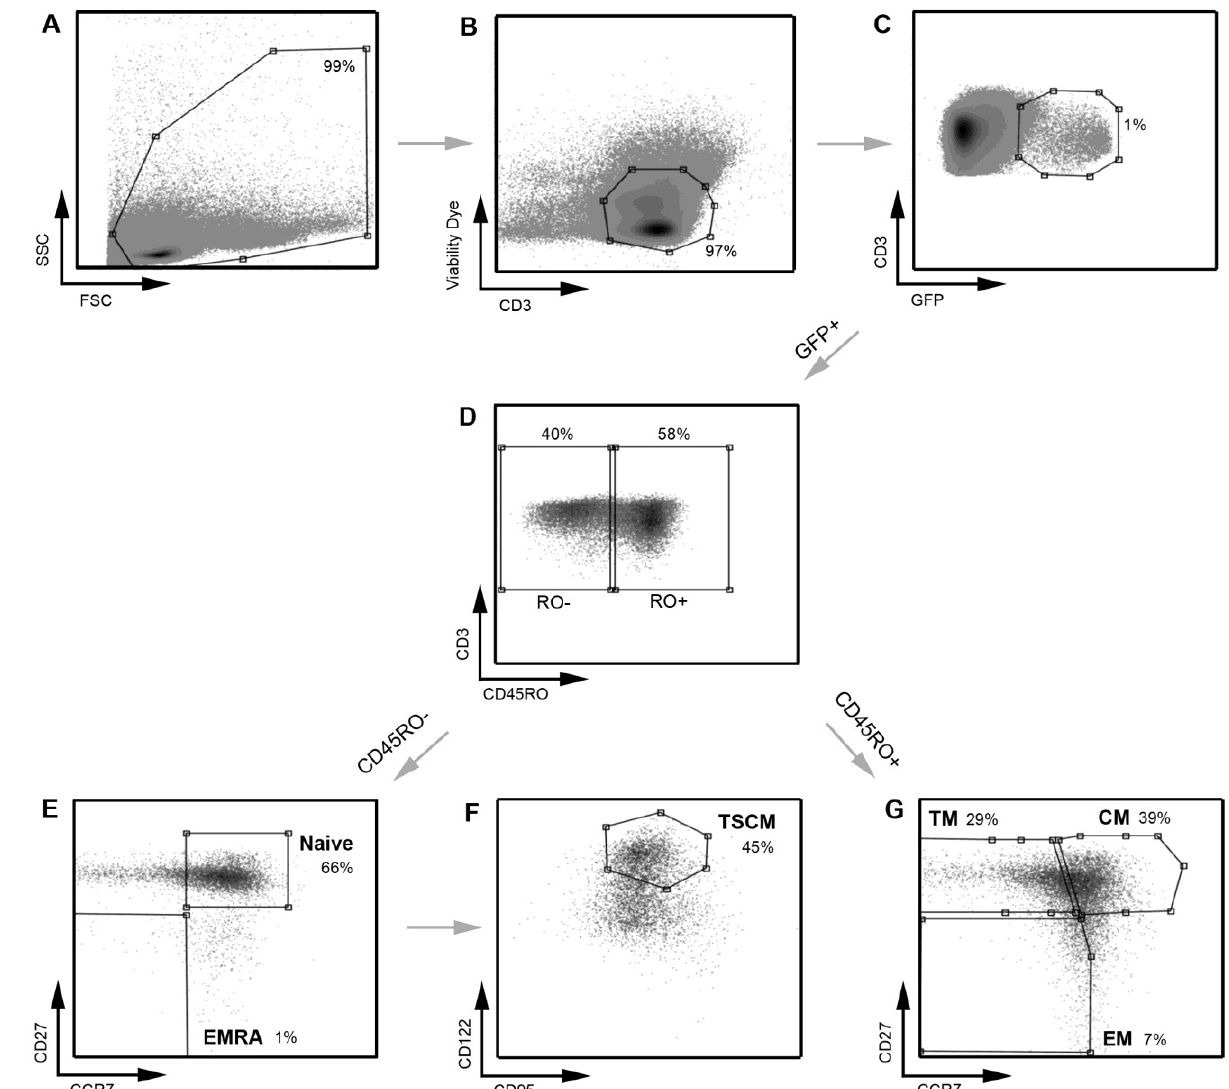
Figure 4. A representative example of the strategy used to define infected CD4 + T cell subsets. A similar gating strategy to that shown in Figure 1 was applied for the detection of infected CD4 + T cells. CD4 + T cells infected with a subtype C CCR5-using Env-pseudotyped GFP reporter virus (258-E-5) were first gated on ( A ) FSC vs . SSC and then ( B ) viable CD3 + T cells (as shown in Figure 1). ( C ) HIV-1 infection was determined by